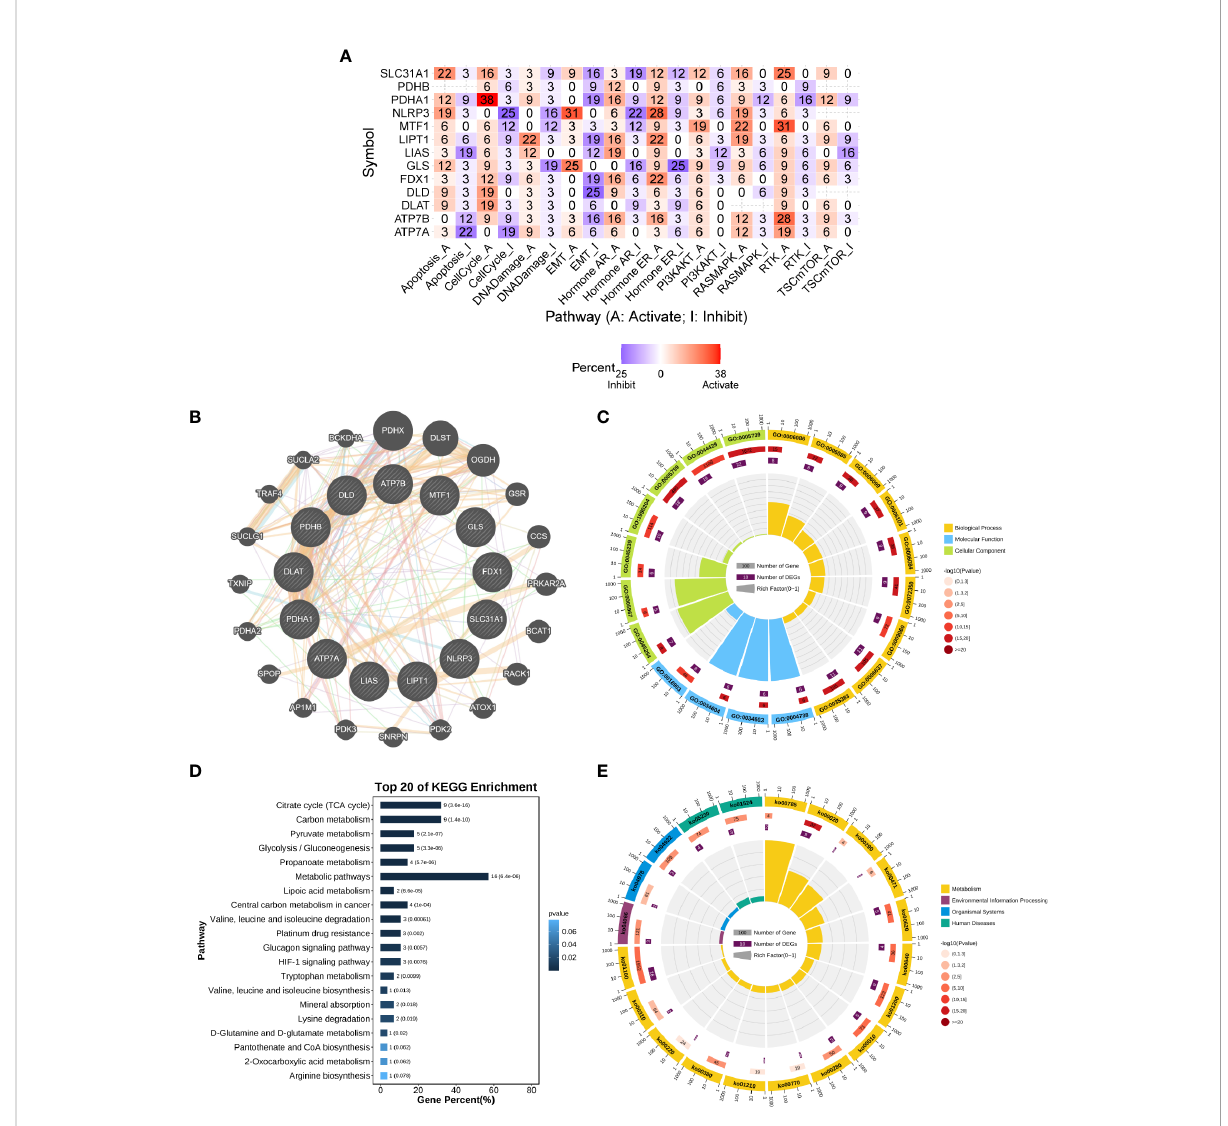
FIGURE 4 Enrichment analysis of cuproptosis-related genes. (A) Combined activity of cancer-related pathways in pan-cancer (GSCALite). (B) PPI network of cuproptosis-related genes (GeneMANIA). (C) GO enrichment analysis. (D, E) KEGG enrichment analysis. The numbers outside the circles are a scale of the number of genes. The fi rst circle is the GO id (or KEGG id) label. The second circle shows the total number of genes in each ID classi fi cation in GO or KEGG and the P-value, the more genes the longer the bar; and the smaller the P-value, the redder the color. The third circle shows the number of input genes in each ID classi fi cation. The fourth circle shows the RichFactor value (the ratio of input genes to the total number of classi fi ed genes in this classi fi cation) for each classi fi cation, with each cell of the background auxiliary line indicating 0.1. GO, Gene Ontology; KEGG, Kyoto Encyclopedia of Genes and Genomes; PPI, protein – protein